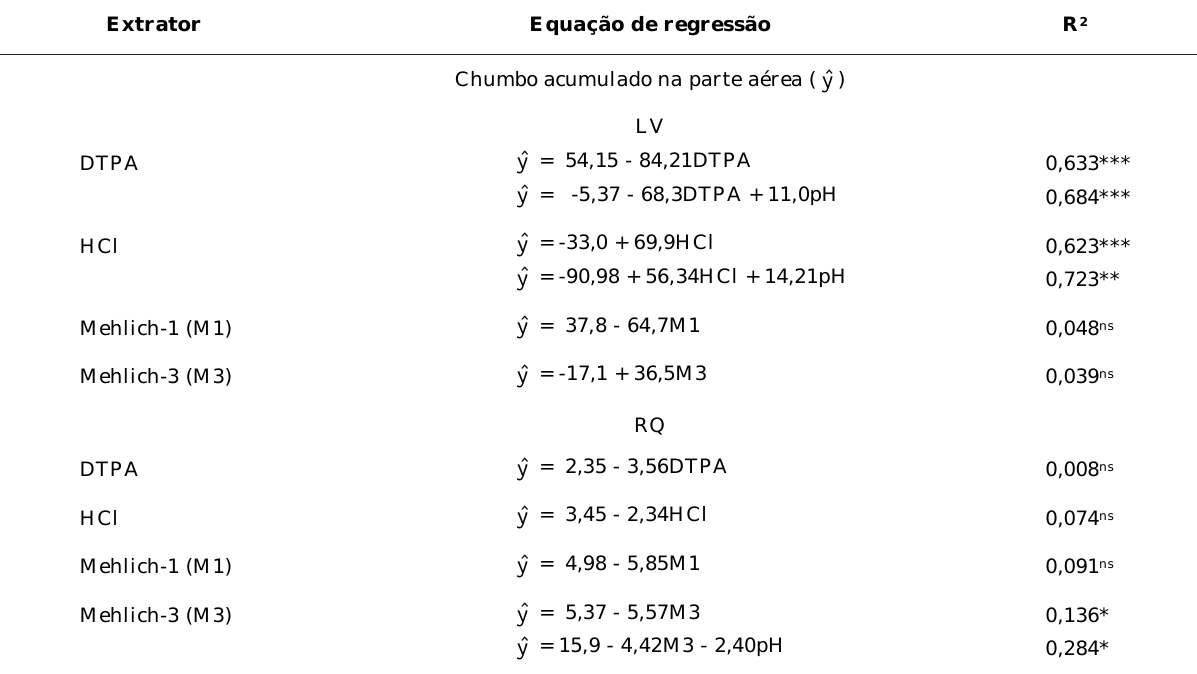
(Figura 2), verificou-se efeito significativo da aplicação de corretivos na extração do elemento pelo DTPA (Quadro 4). A maior sensibilidade do DTPA a alterações na disponibilidade de Zn, decorrente da variações no pH do solo, foi apontada por diversos autores (Korcak & Fanning, 1978; Camargo et al., 1982; Shuman,